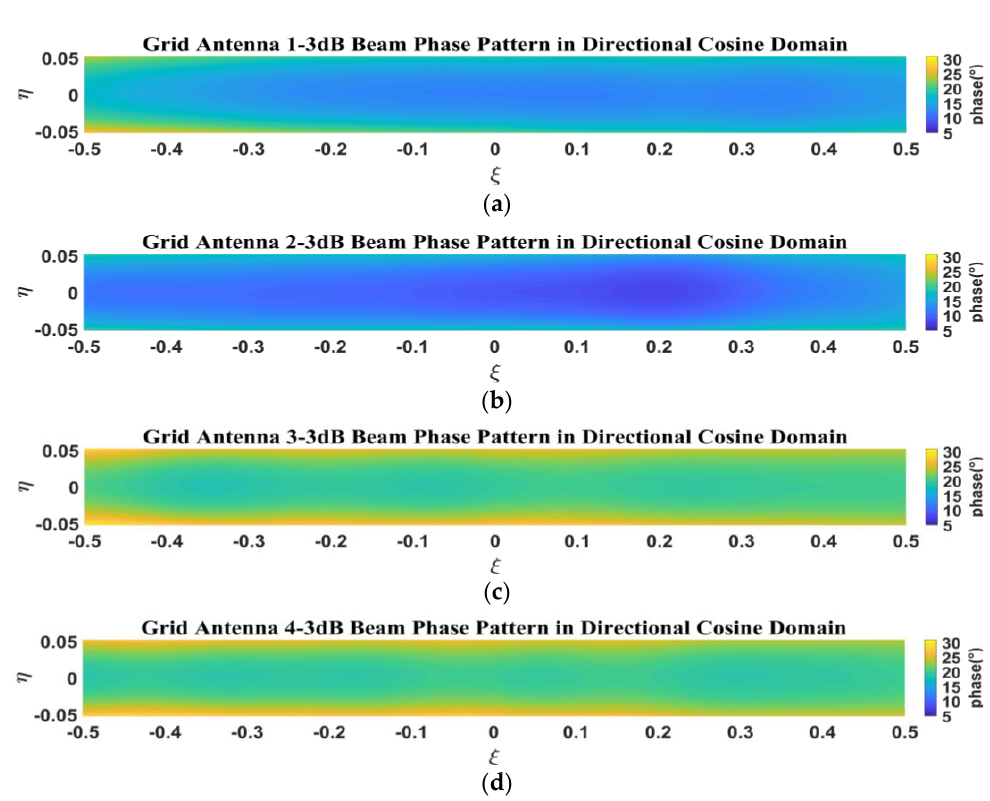
Figure 11. Simulated phase pattern of 3-dB beamwidth in direction cosine domain: ( a ) grid antenna 1; ( b ) grid antenna 2; ( c ) grid antenna 3; ( d ) grid antenna 4.